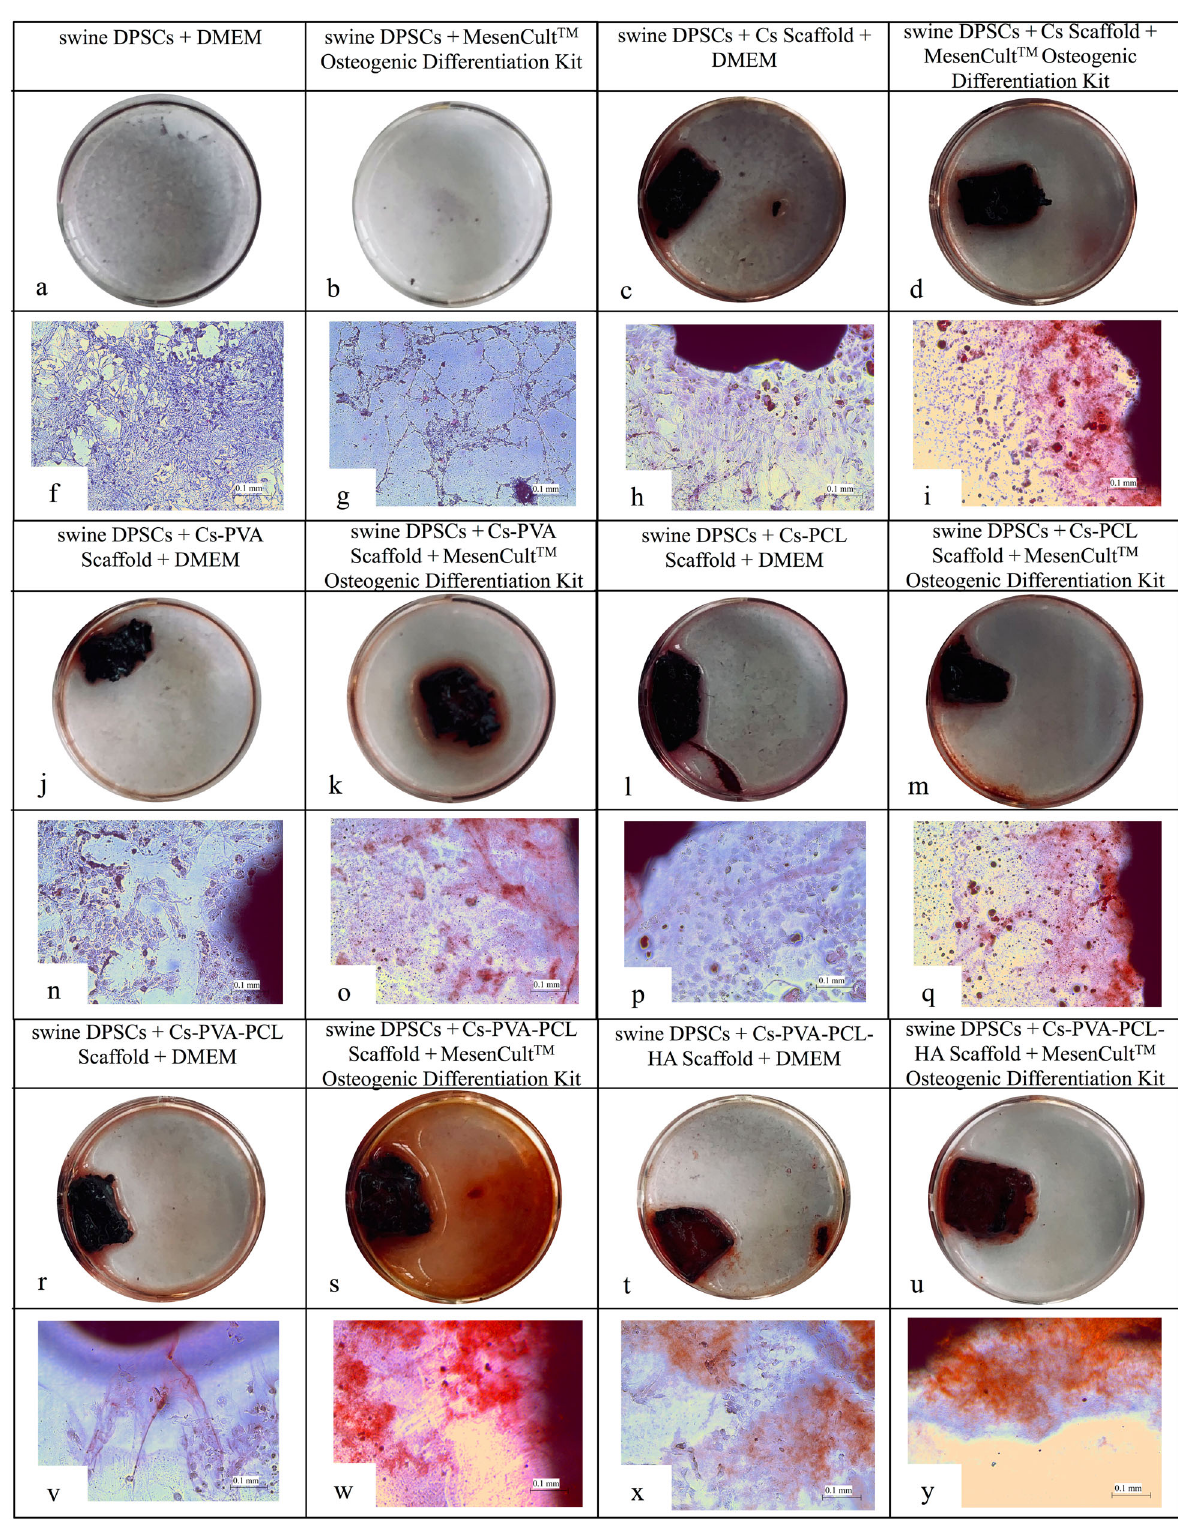
Fig. 6 Representative images of the mineral deposition in swine DPSCs on day 28 by Alizarin red S staining ( a – d , j – m and r – u ) and microscopy images ( f – i , n – q and v – y ) at the bottom